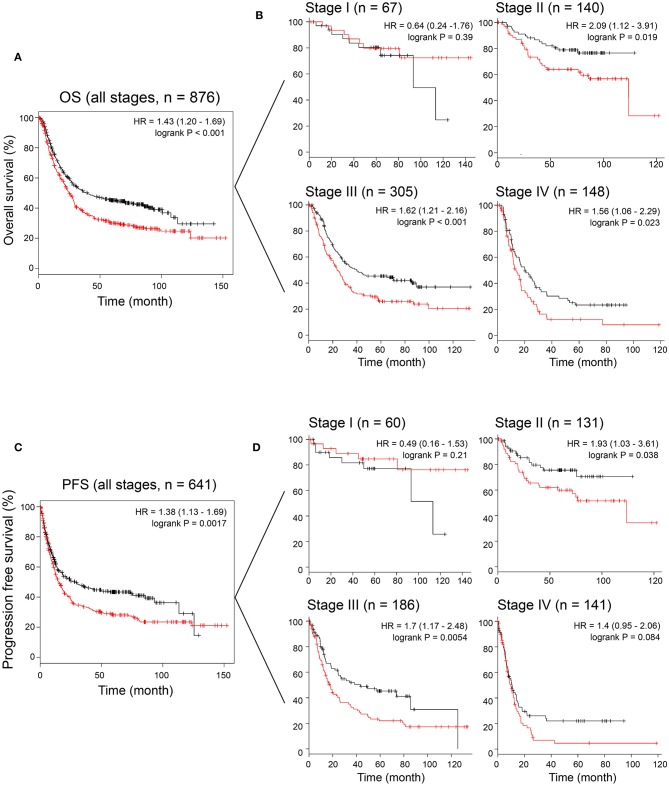
The association between MAGP1 mRNA expression and prognosis of gastric cancer using K–M plotter data with the Affy ID 203417_at. (A) Overall survival and (B) disease free survival were showed between high (red) and low (black) expression group using K–M plotter data. (C) Overall survival was showed between high (red) and low (black) expression group in stage I–IV. (D) Progression free survival was showed between high (red) and low (black) expression group in stage I–IV.